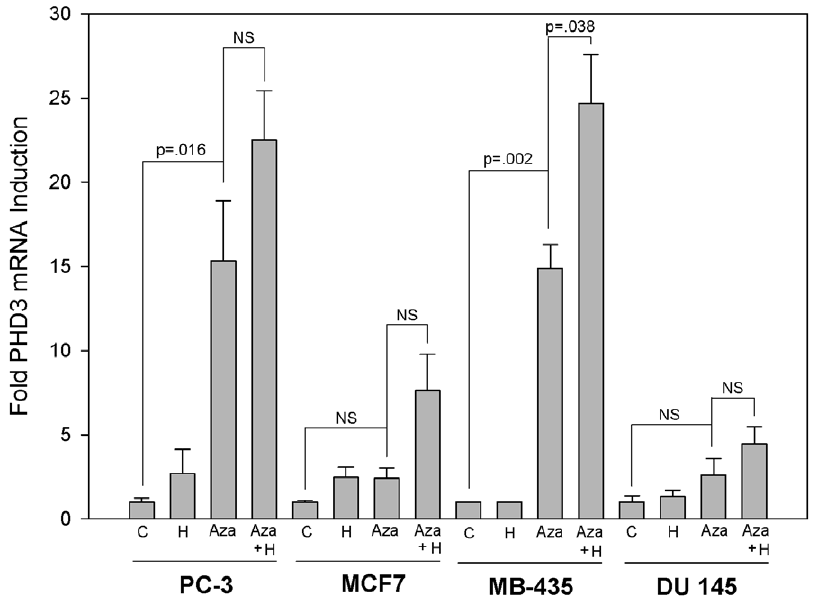
Figure 2. Treatment with 5-Aza-dC triggers re-expression of PHD3. Cell lines representative of PHD3 expressers and PHD3 non-expressers were either not treated (C), treated with hypoxia (H), treated with 5-Aza-dC (Aza), or treated with 5-Aza-dC and then subjected to 1% oxygen (Aza + H) according to the protocol described in Materials and Methods. Real time quantitative PCR was performed to determine the mRNA expression of PHD3. The data were normalized to GAPDH and expressed relative to PHD3 mRNA in the corresponding untreated controls. Error bars = SEM. n=3.